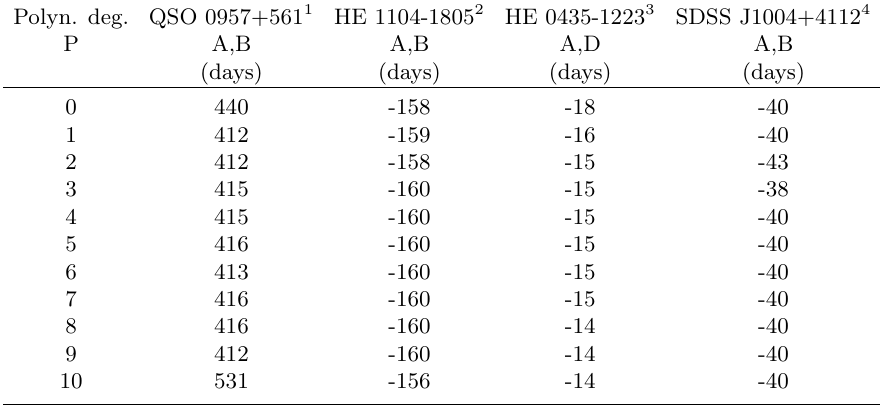
Table 2. Trend effect on time